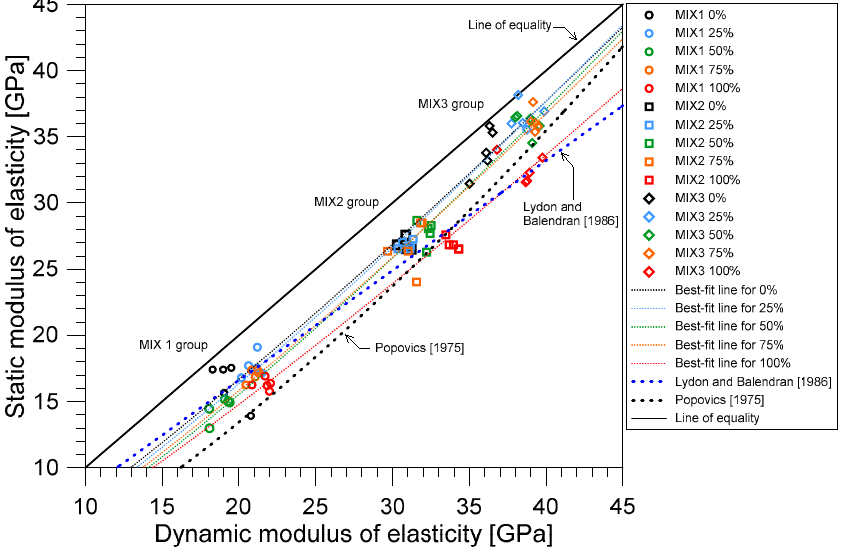
Figure 14. The relationship between static and dynamic elastic moduli of water-saturated concrete.